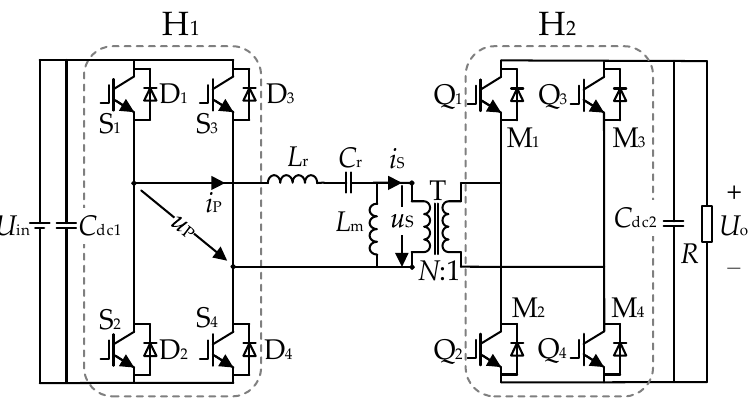
Figure 1. Topology of an LLC-DAB DC-DC converter. In the LLC-DAB DC-DC converter, the two H-bridges are coupled with the high- frequency transformer through the LLC resonant tank. Each of them can be regarded as an inverter unit to generate high-frequency AC voltage square waves. In the power transfer process, the inductor is the key component for bidirectional power transfer, which completes the charging and discharging in one switching period. The high-frequency transformer plays the role of electromagnetic isolation and voltage matching. The LLC-DAB DC-DC converter can be represented by the equivalent circuit model shown in Figure 2. The two AC voltage sources, u P and u S, are connected through an LLC resonant tank. The magnitude and direction of the power transmitted by the converter are determined by the amplitude, phase and frequency of the voltages on both sides of the LLC resonant tank. Power is transmitted from the P side to the S side for forward power flow when the phase angle difference between the voltages of the two sides is positive. On the contrary, power is transferred from the S side to the P side when the phase angle difference is negative. The power of DAB is always transferred from the phase-leading side to the phase-lagging side.